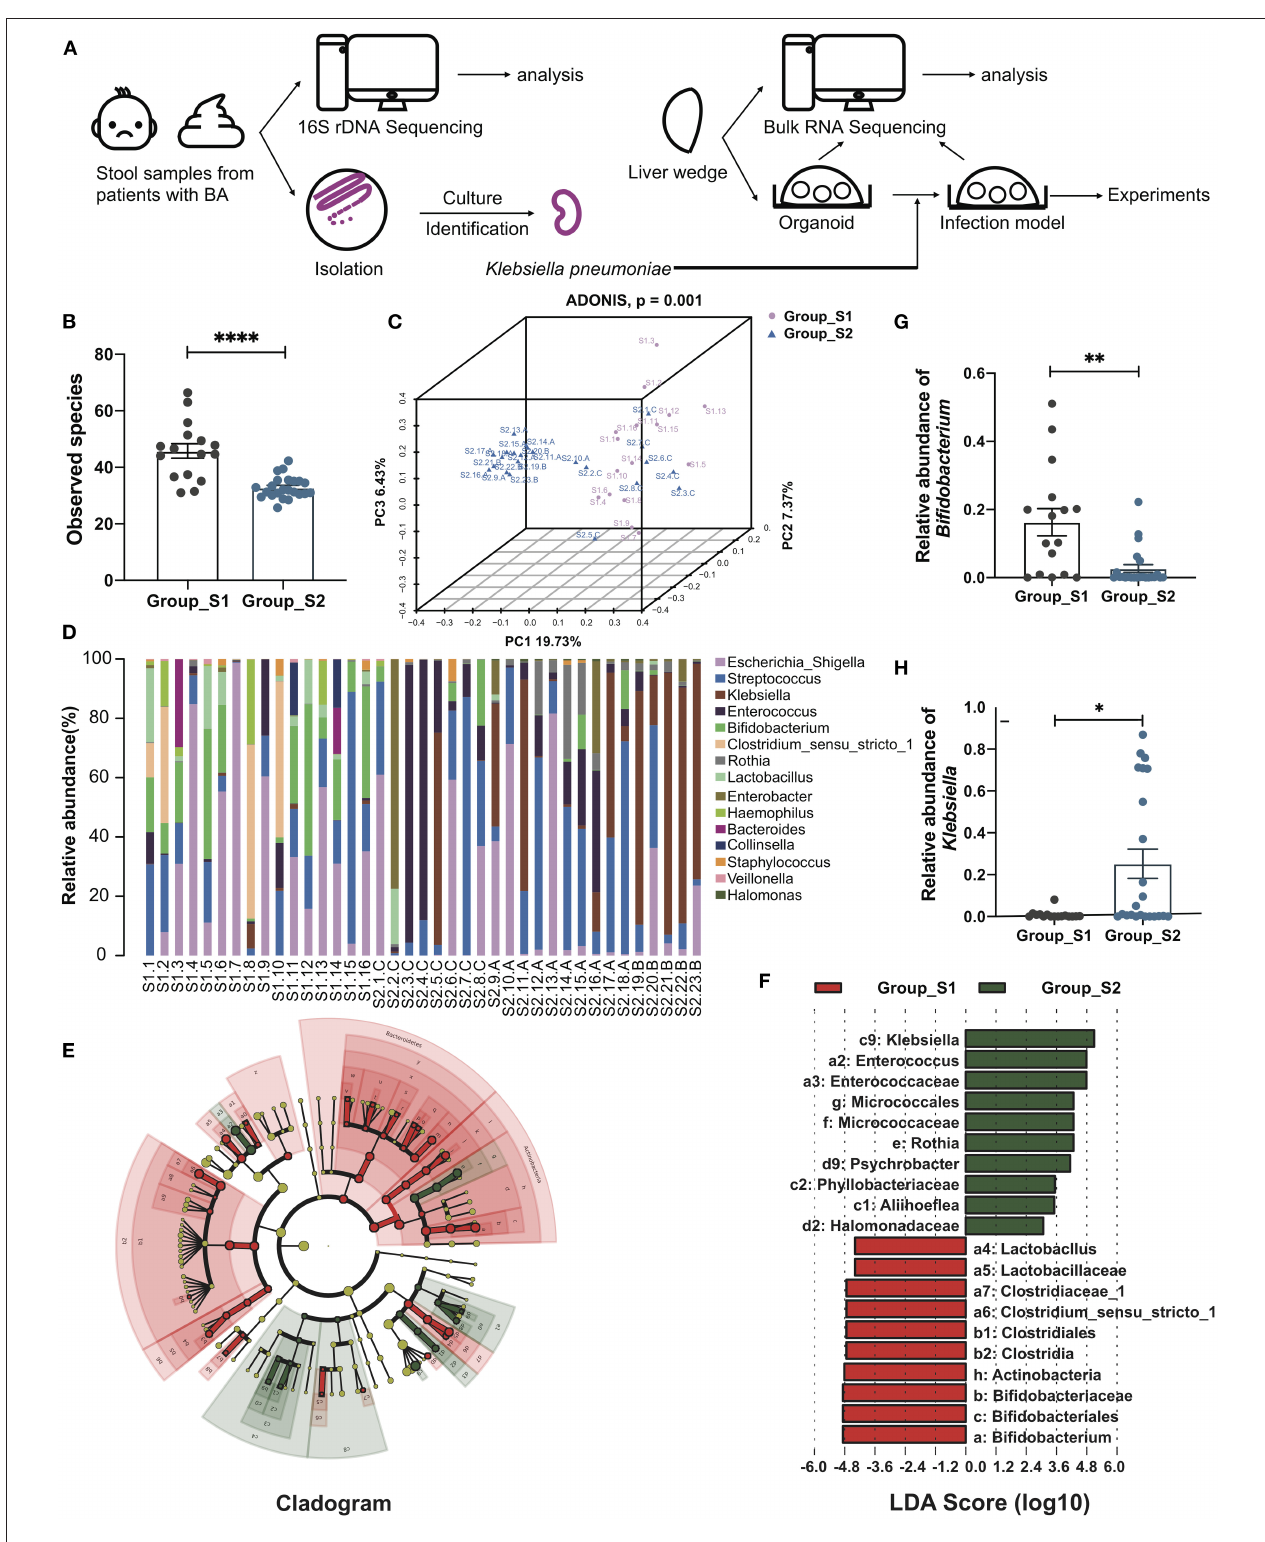
FIGURE 1 | Distinct gut microbiome composition before and after Kasai surgery. (A) The whole workflow of this study. (B) Bar plot of observed species in patients before (Group_S1, n = 16) and after (Group_S2, n = 23) Kasai surgery. Statistical differences were analyzed by Mann-Whitney test. (C) Beta diversity PCoA plot